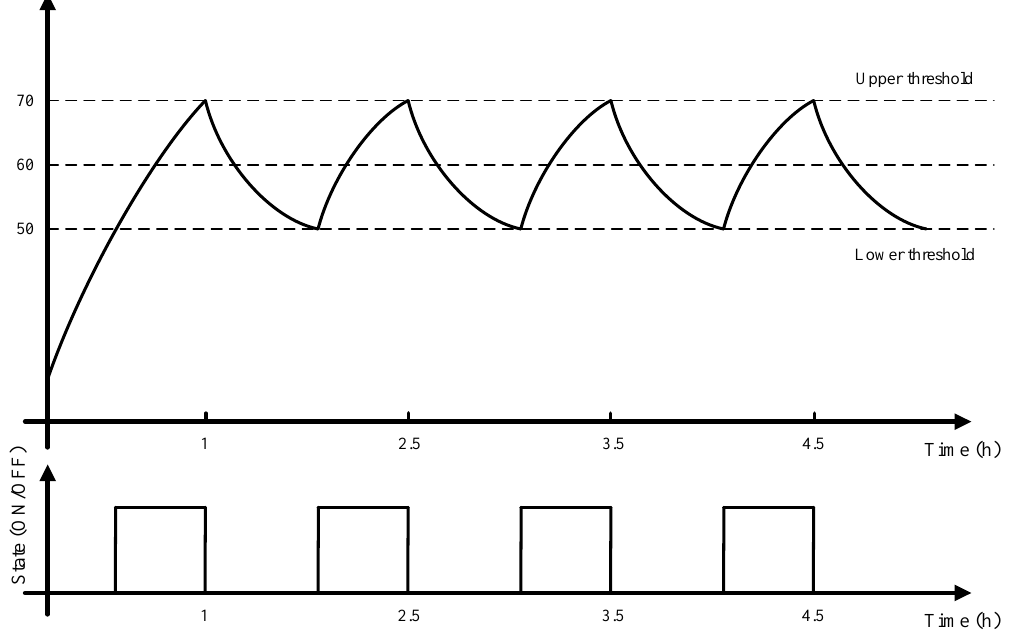
Figure 1. The water temperature curve in a domestic electric water heaters (DEWH) tank.